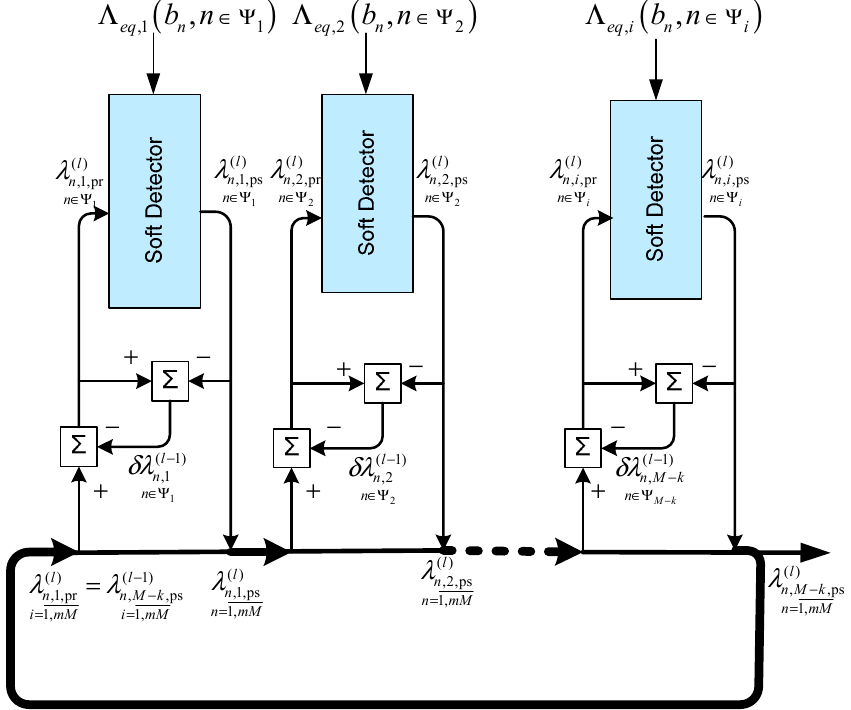
Figure 4. Block diagram of a single-signal Turbo processing using a sequential multi-step procedure for a Markov approximation model.